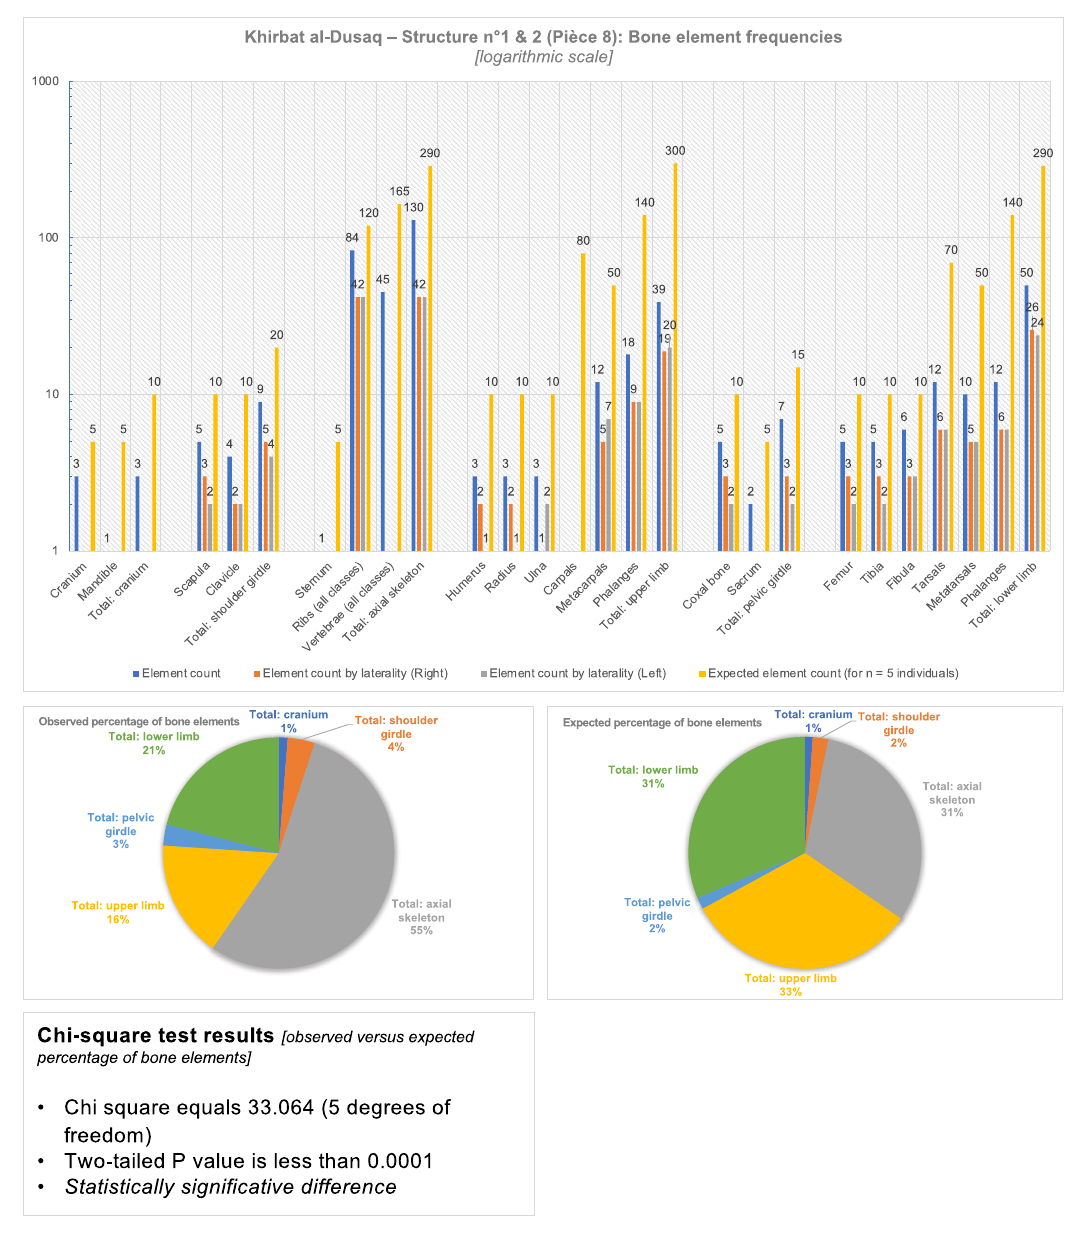
Figure 15: Structure no 1 and 2 ( Pièce 8 ) : bone element frequencies ( top ) and percentages ( bottom ) . Figures by Hofstetter ( 2022 )